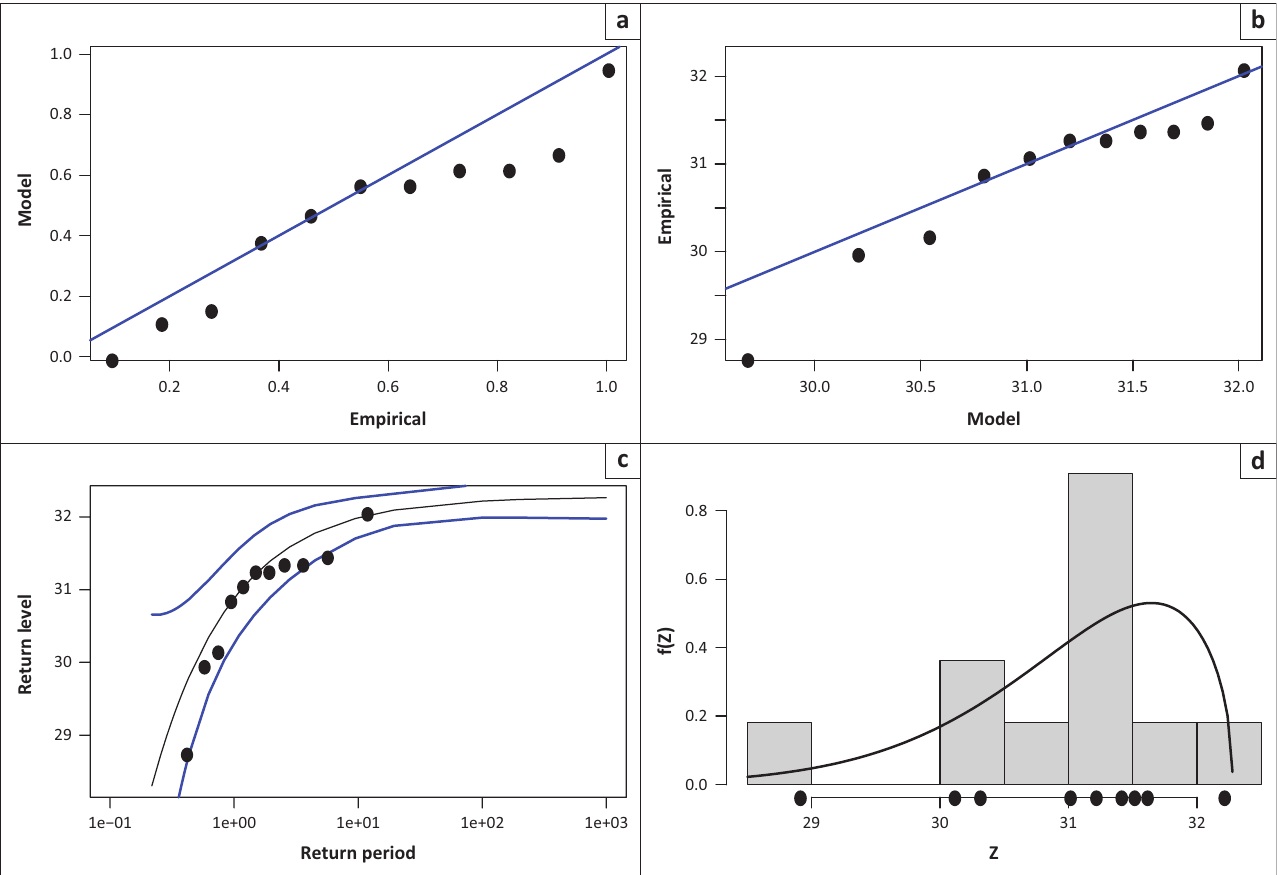
FIGURE 3-A1: Diagnostic plots illustrating the fit of the data (annual average maximum temperature) to the generalised extreme value distribution for r largest order statistics model with = 4, (a) probability–probability plot for k = 4, (b) quantile–quantile plot for k = 4, (c) return level plot for k = 4, and (d) density plot for k =